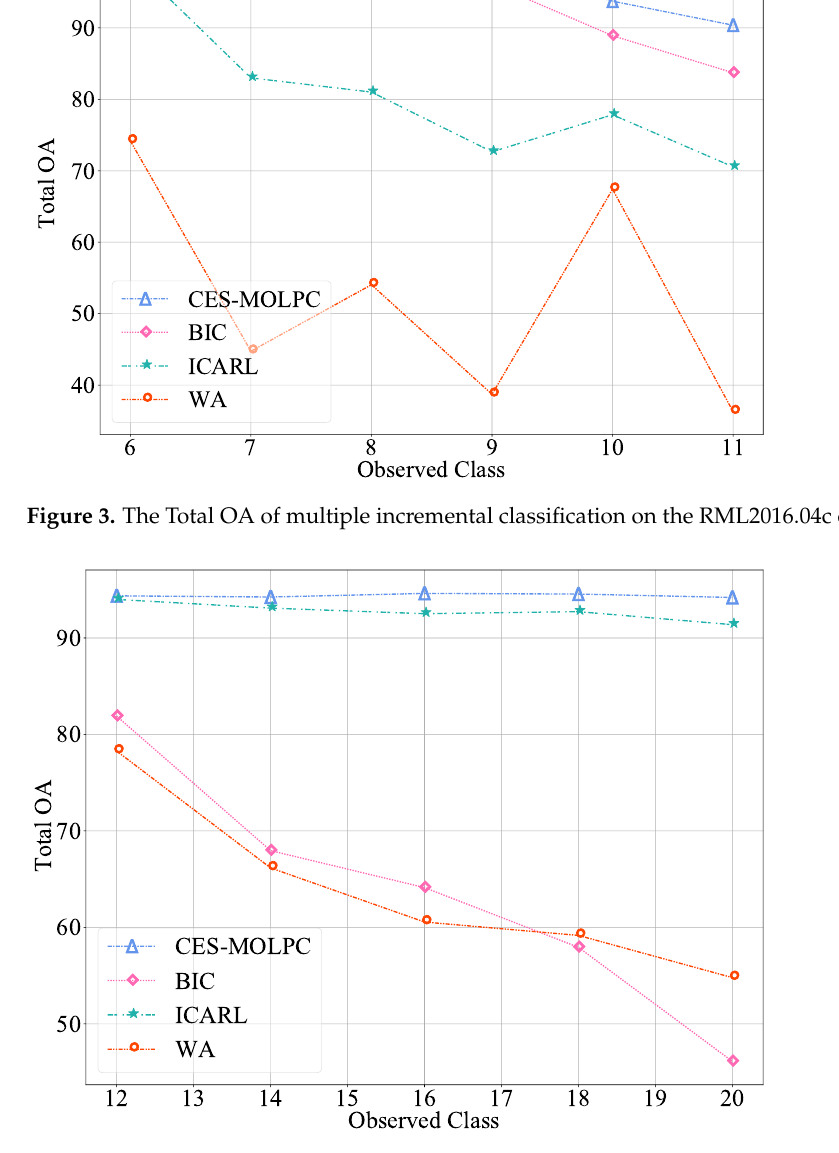
Figure 4. The Total OA of multiple incremental classification on the ACARS data set ( T =